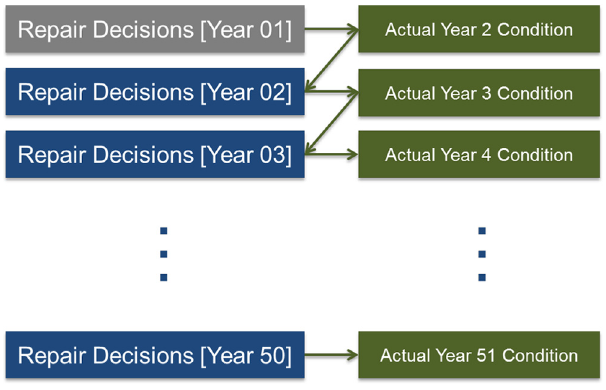
Figure 4. Illustration of the dynamic simulation and decision